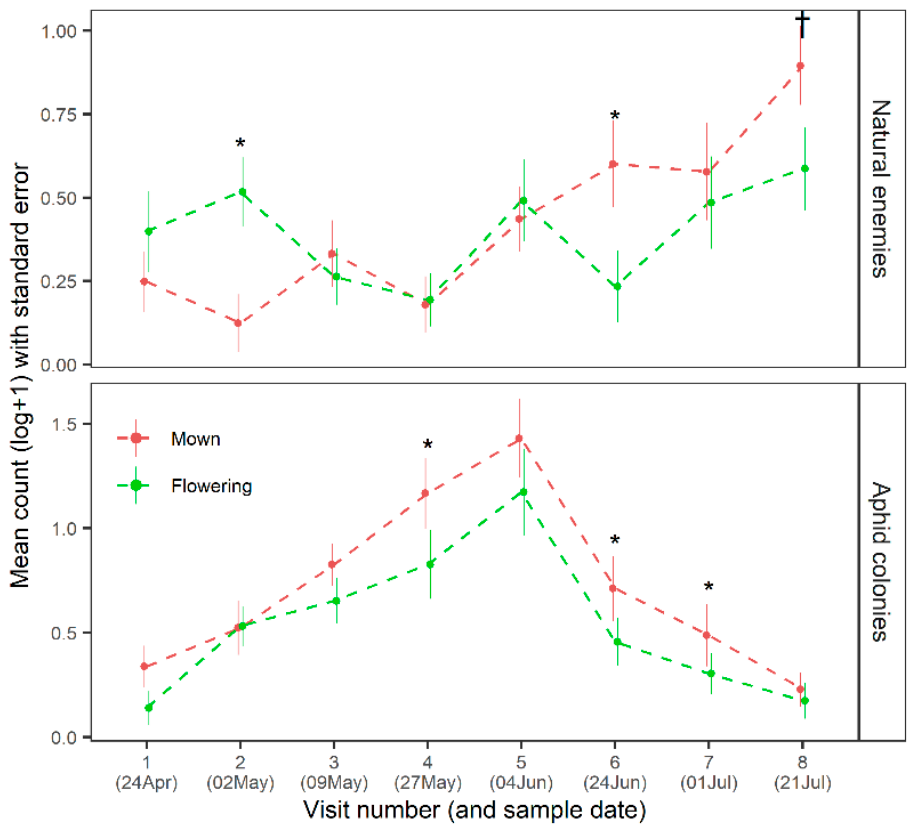
Figure 4. Number of aphid colonies and natural enemies on apple trees across the season, above mown and flowering understoreys. Bars represent standard errors. Symbols refer to p -values, where * < 0.05, † < 0.1. See Table S6 for model outputs. Table 4. Effects of understorey management on apple damage, according to negative binomial GLMMs. Positive estimated regression parameters represent association with flowering understoreys. ‘Other insect damage’ includes Cydia pomonella , Operophtera brumata , and capsid damage, which were too infrequent to be analysed separately. Apple Damage Estimate Standard Error Z Value P -Value Aphids − 0.846 Other insect